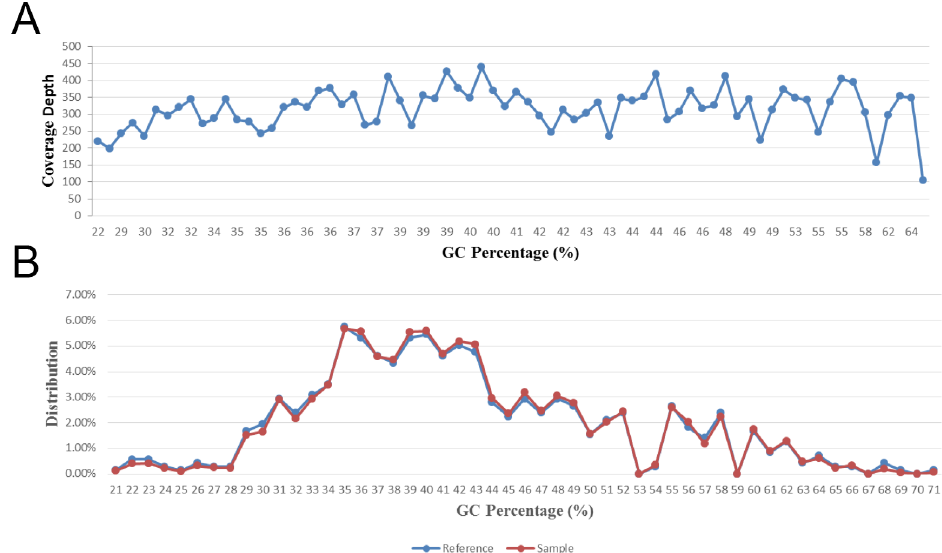
Fig 4. GC content. (A) Average depth distribution of all 100-basewindowsas a function of GC content. From GC content 22% to 69%, the averagedepth of each windowin the genomefluctuates in a small range. (B) GC patterns of the reference genome and